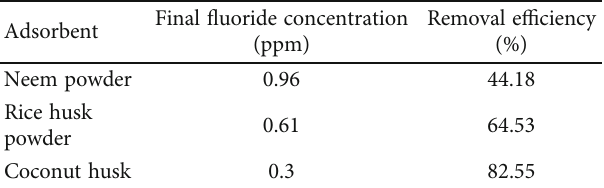
Table 1: Fluoride removal e ffi ciency in groundwater. Adsorbent